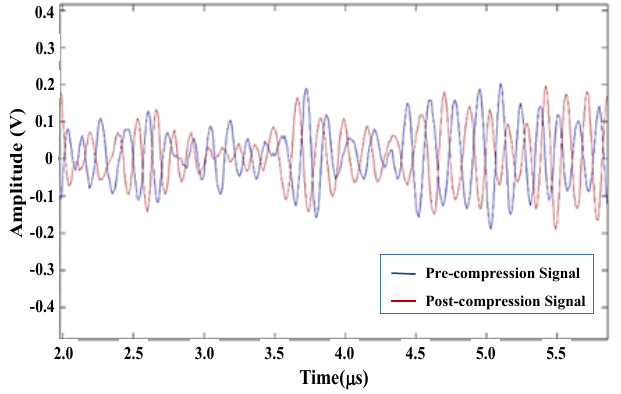
Figure 10. The signals of pre ‐ and post ‐ compression with time shift. Materials 2015 , 8 , page–page